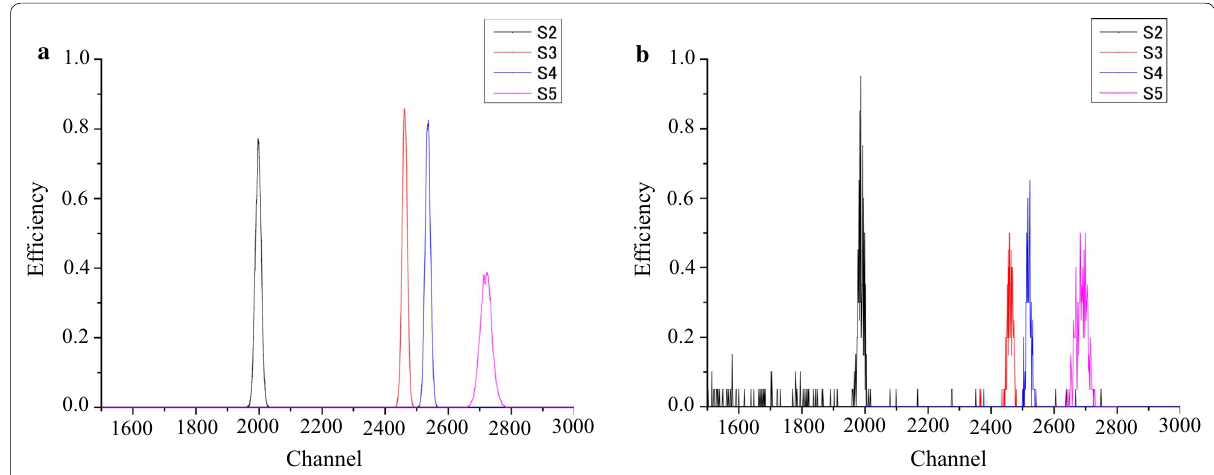
Fig. 9 a The result of the ground experiment inputting the calibration signals at TKSC and b the result of the in-flight experiment inputting calibration signals on the